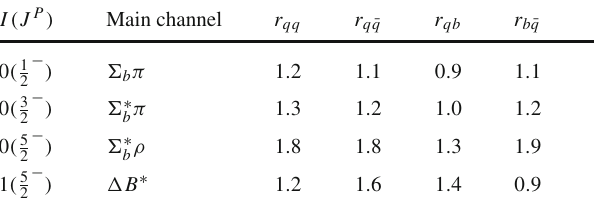
Table 18 The RMS distances of the qqq ¯ qb pentaquark system